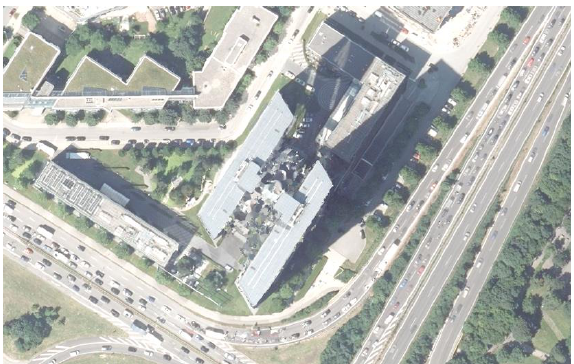
Figure 6. DSM-Error caused by occluded areas